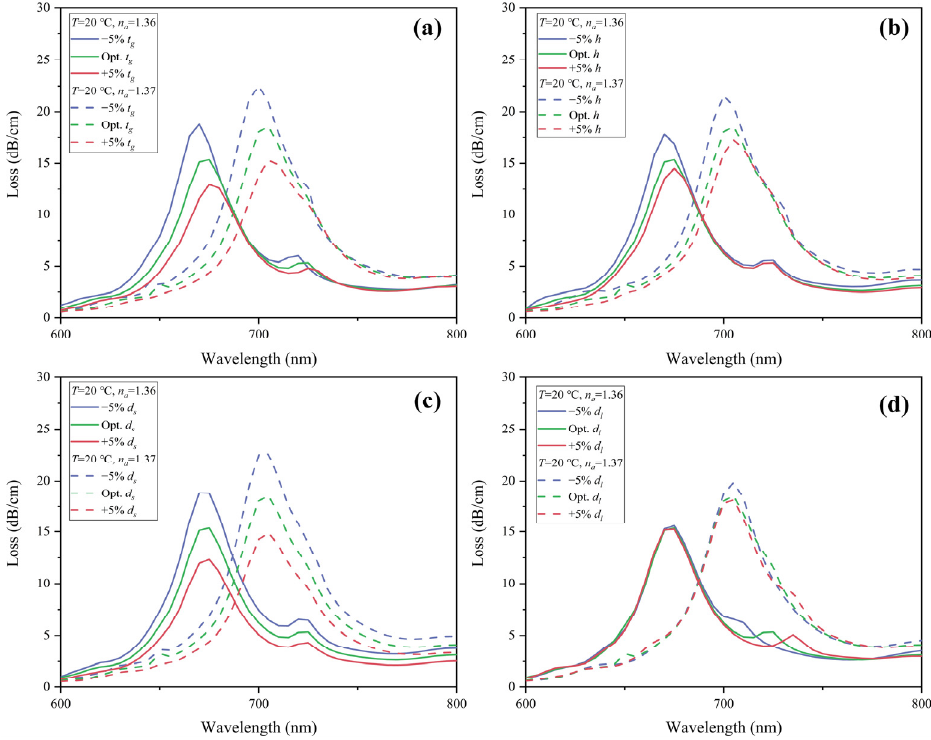
Figure 12. Tolerance test on RI sensing channel of the structure parameter ( a ) t g , ( b ) h , ( c ) d s , and ( d ) d l for ±5% deviation.